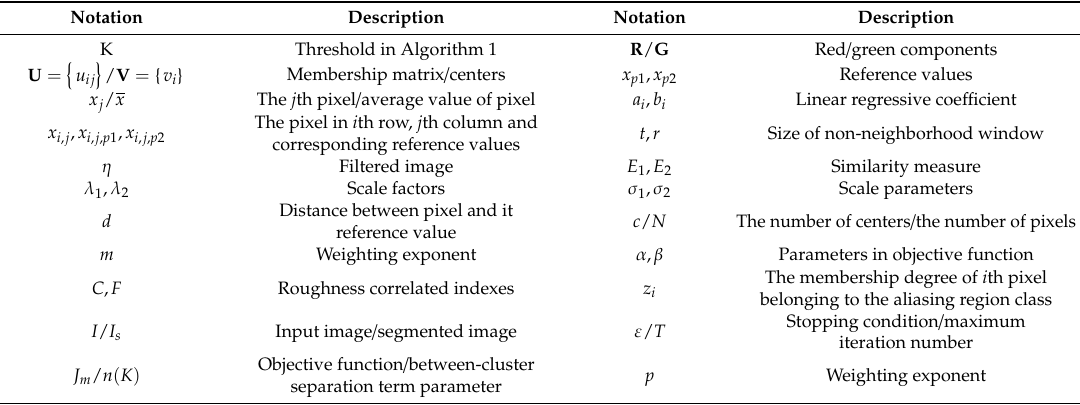
Table 1. Notations and their descriptions used in the proposed algorithm.